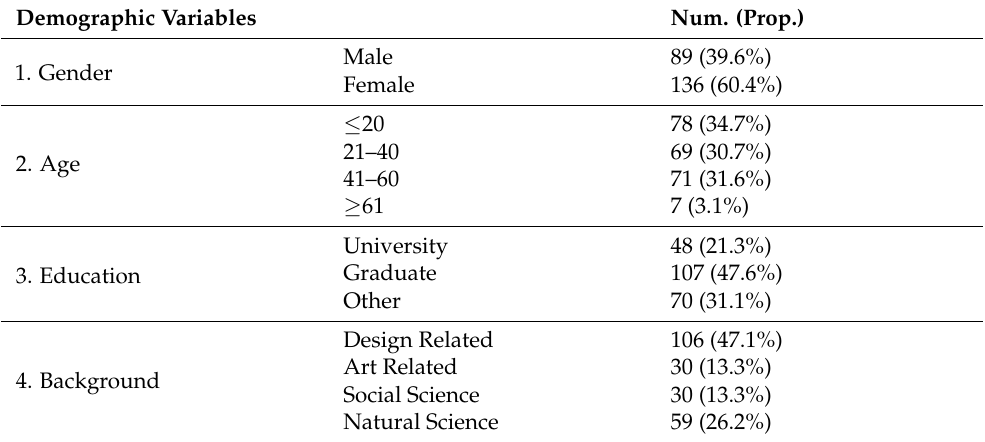
Table 2. Distribution of